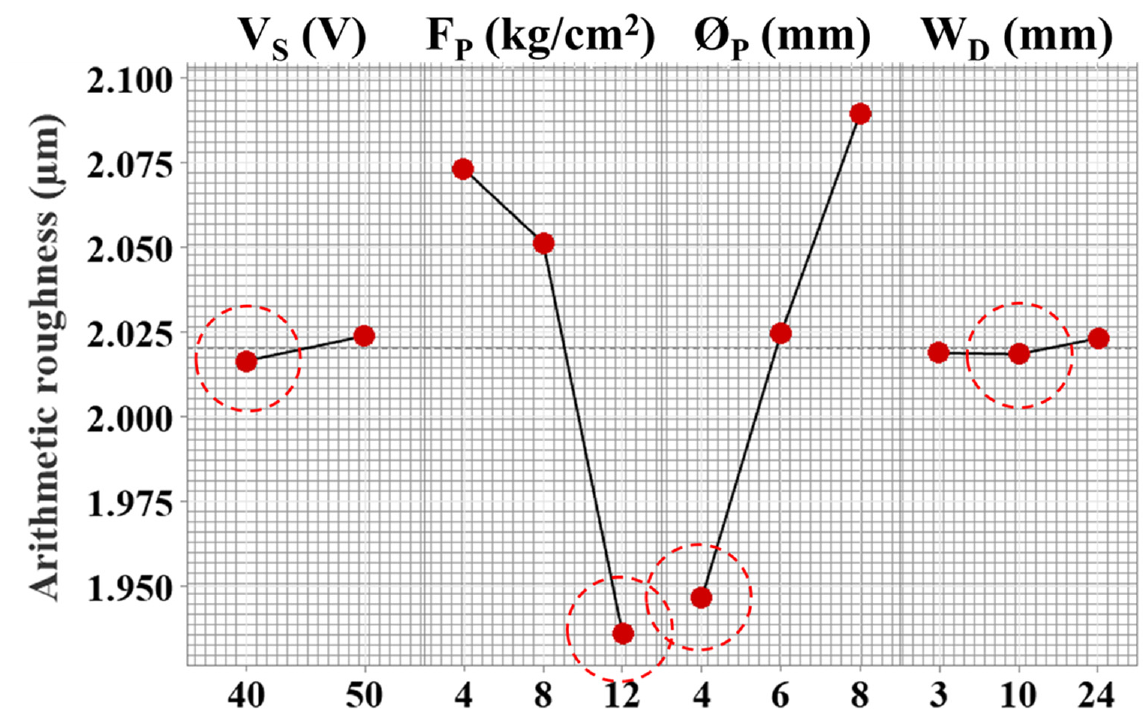
Figure 7. Parametric effects on surface roughness of complex profile machining and red circles indicating desired parametric level.